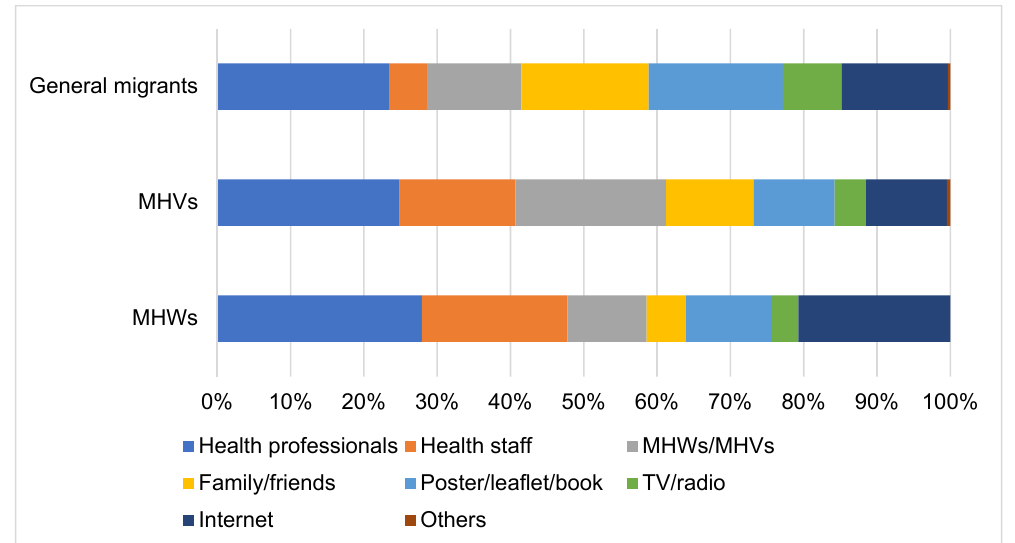
Figure 2. Channel of health information classified by types of migrants. (maximum three answers by each respondent). MHWs: migrant health workers; MHVs: migrant health volunteers.